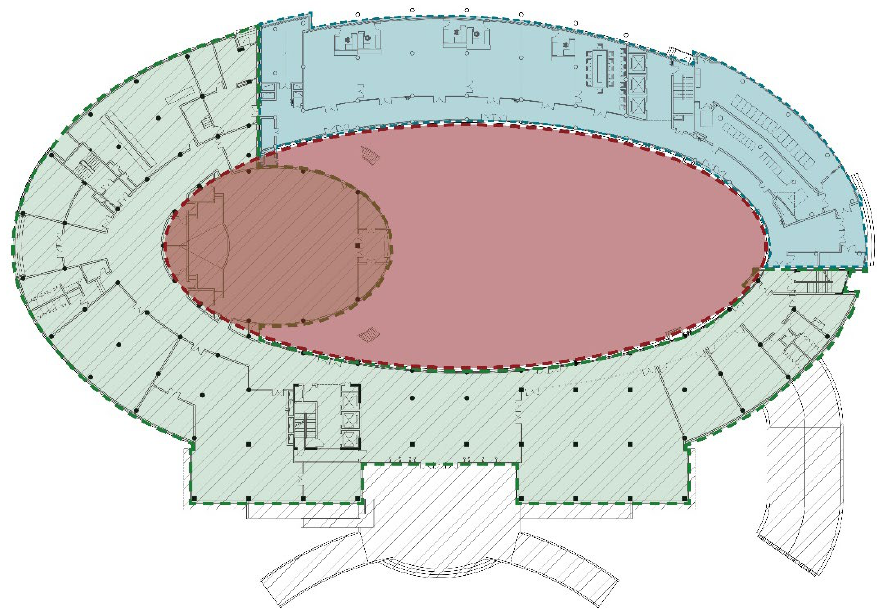
Figure 1. The 1st plan of the current building.